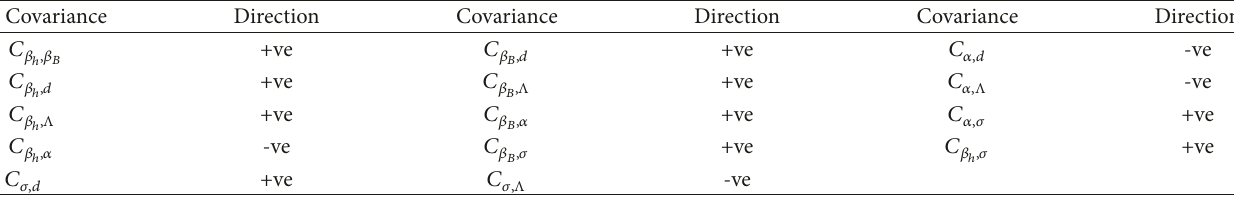
Table 5: Covariance of the